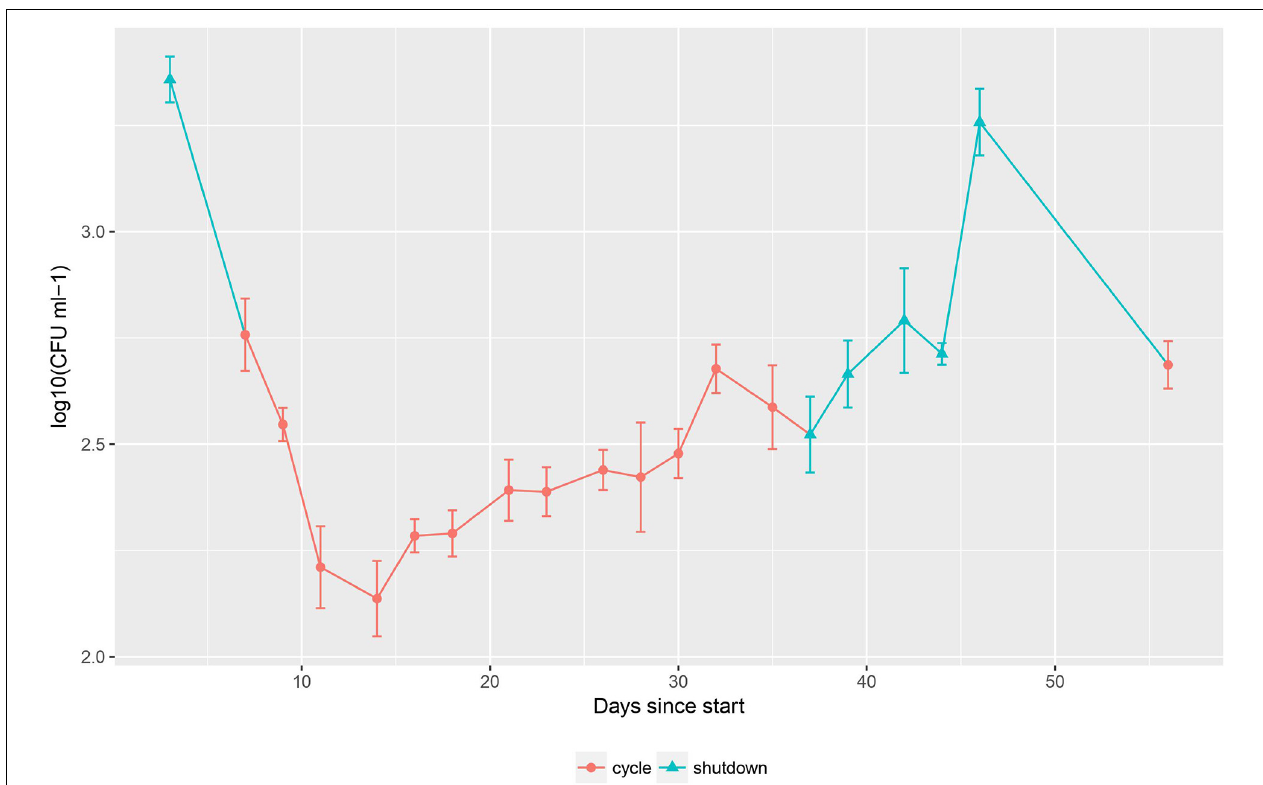
FIGURE 2 | Cell counting during the second sampling campaign. Error bars represent standard deviation, n = 3. Cycle and shutdown periods are indicated by red circles and blue triangles, respectively.